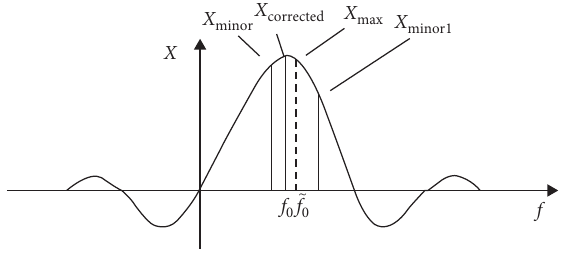
Figure 13: Interpolation correction